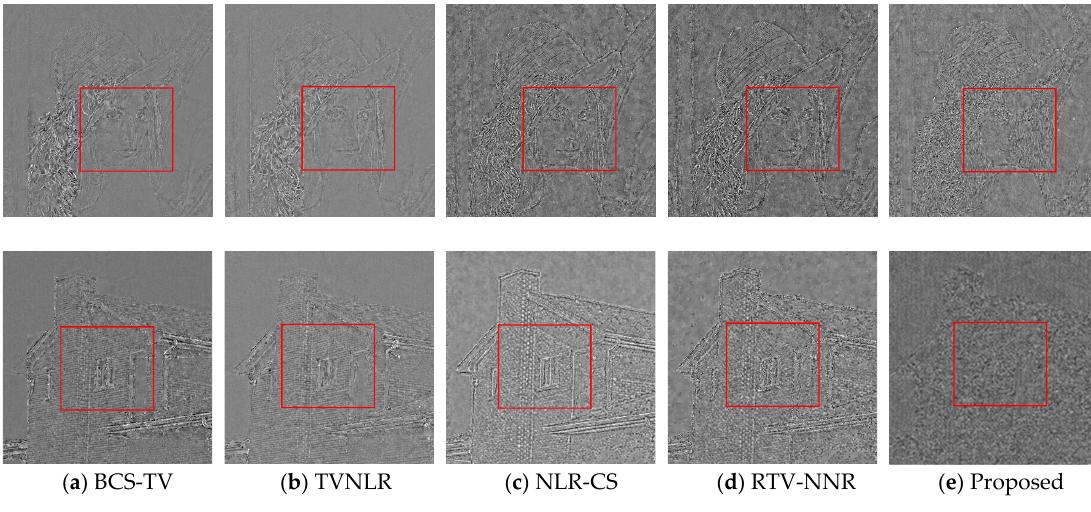
Figure 7. The residual errors obtained by five methods. Table 2. The values of the structural similarity index (SSIM) for the different images (ratio: 0.05). Image